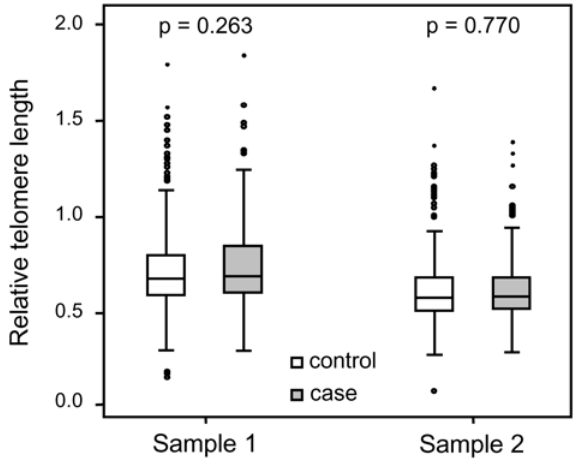
Figure 3. Blood RTL could not predict future tumor develop- ment. There was no difference between future tumor patients and controls regarding RTL measured $ 9 years before diagnosis (RTL sample 1) or measured 0–11 years before diagnosis (RTL sample 2).